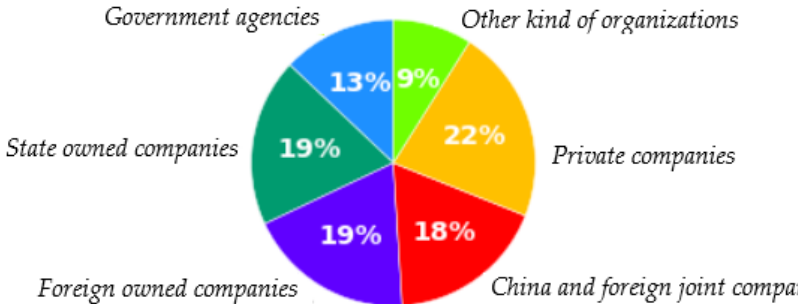
Figure 1. Respondents for question of which industry are you from? About 40% of the respondents were from financial-related industries, and the other 60% were from other industries (Figure 2, Table A3).